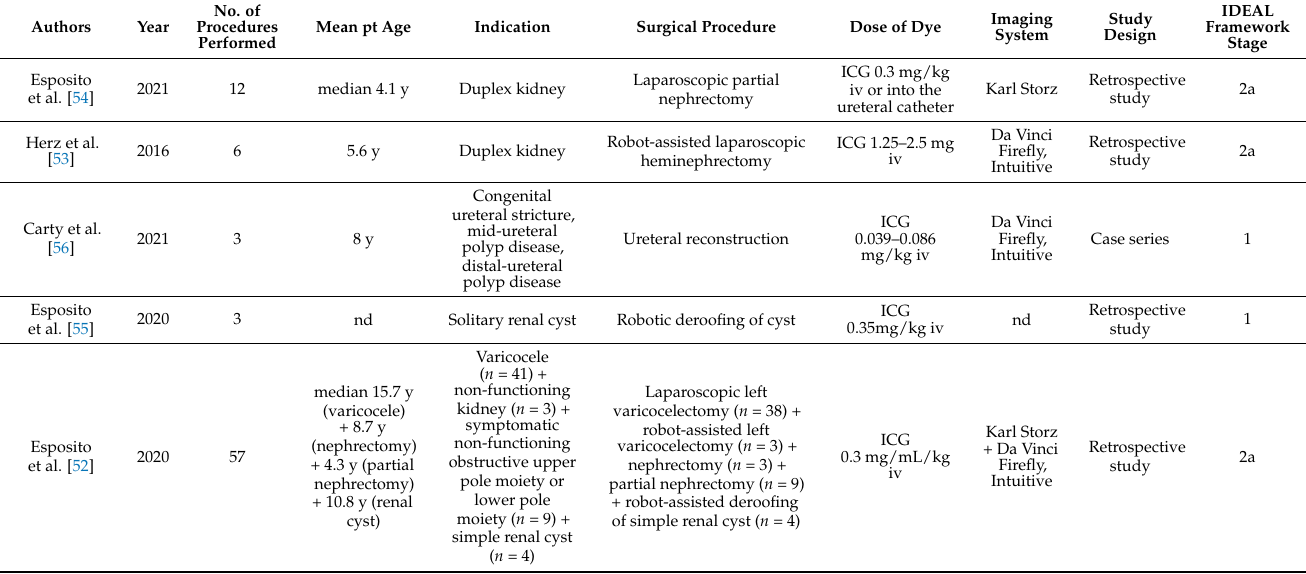
Table 5. Summary for urogenital